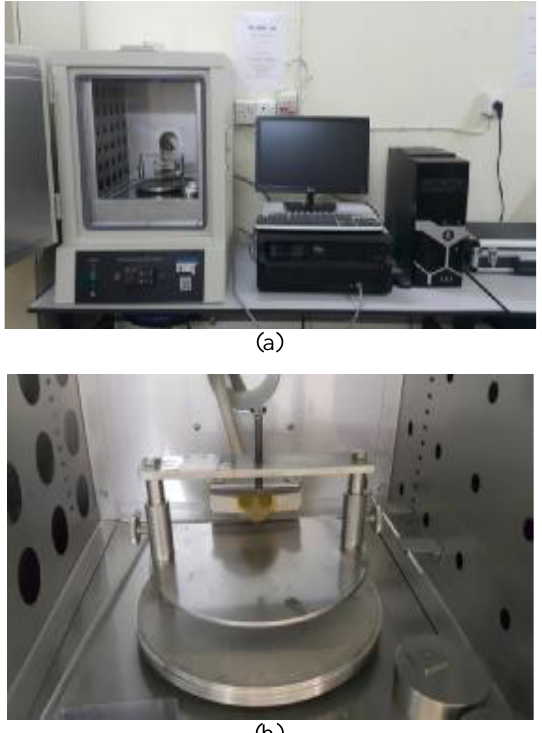
Fig. 3. (a)Thermal properties apparatus, (b) Holder of the sample. Physical property requirements for shaped and unshaped refractories are different. For shaped refractories, the main requirements are their density and porosity and dimensional tolerance, which achieved in the present